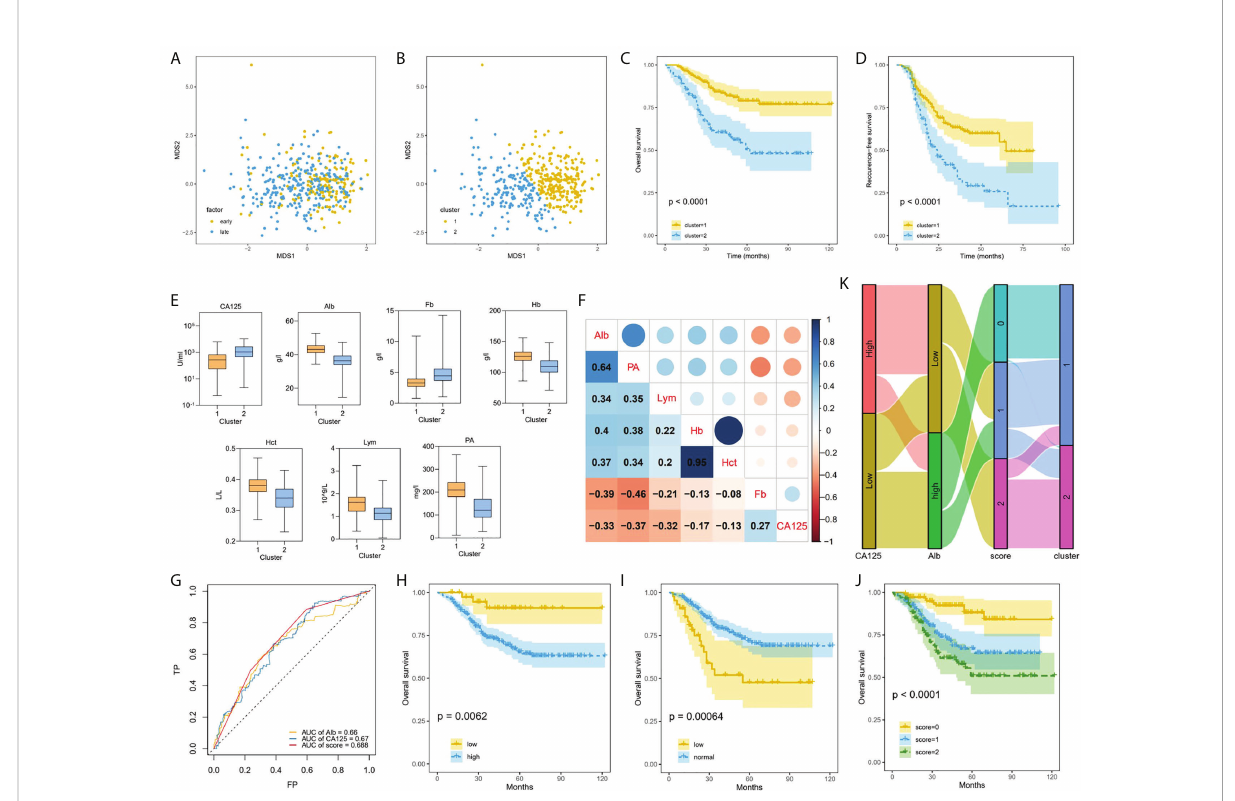
FIGURE 4 Machine learning using unsupervised clustering analysis associated with prognosis. (A) , Applied MDS technique to reduce dimension and generated MDS plot. (B) , EOC patients clustered into two groups using K-means method. (C, D) Kaplan – Meier curves showed OS (C) and RFS (D) of each cluster in all EOC. (E) , Box plots representing distribution of top seven differential blood markers between the cluster 1 and cluster 2. (F) , Correlation between top seven differential predictors evaluated using Spearman rank coef fi cient. (G) , Comparing the AUCs of CA-125, ALB and score. (H – J) Performing Kaplan – Meier method on the traditional CA-125 (H) , Alb (I) , and comprehensive score (J) . (K) Sankey plot showed the transition of the values of new CA-125, Alb, and score, and the proportions of